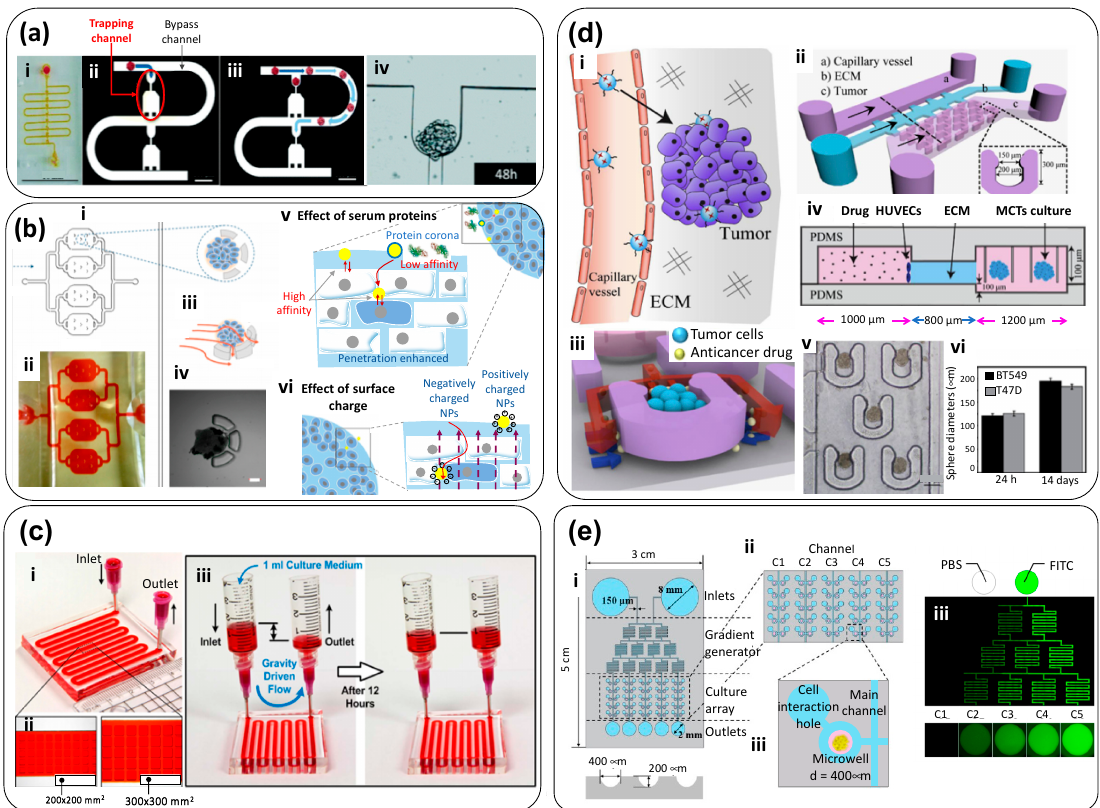
with five semicircular weirs (each with two apertures to allow perfusion flow) that trapped HepG2 multicellular spheroids (~200 μ m) (Figure 3b-iii,iv).